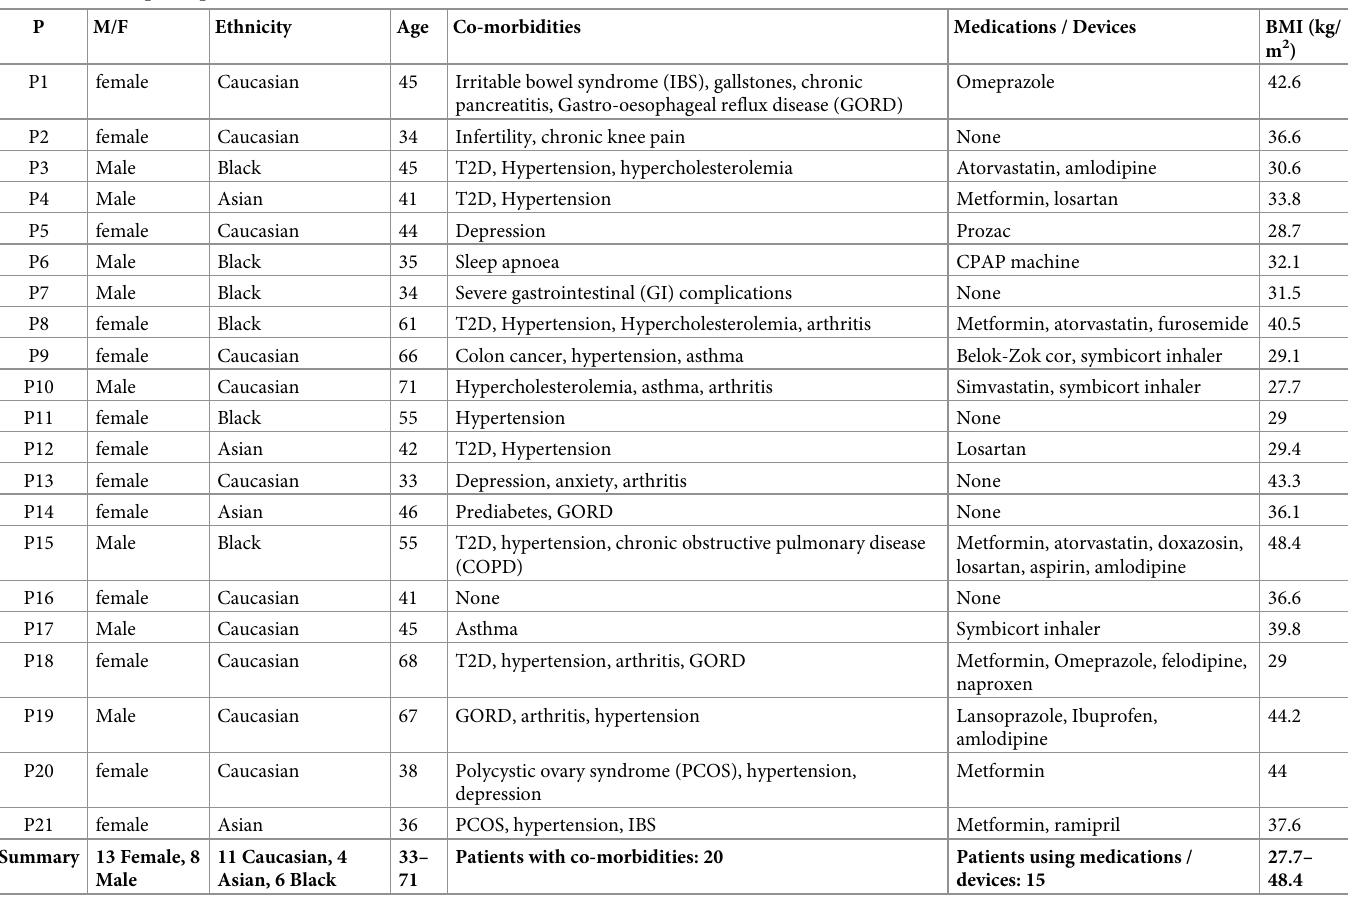
Table 1. Table of participant